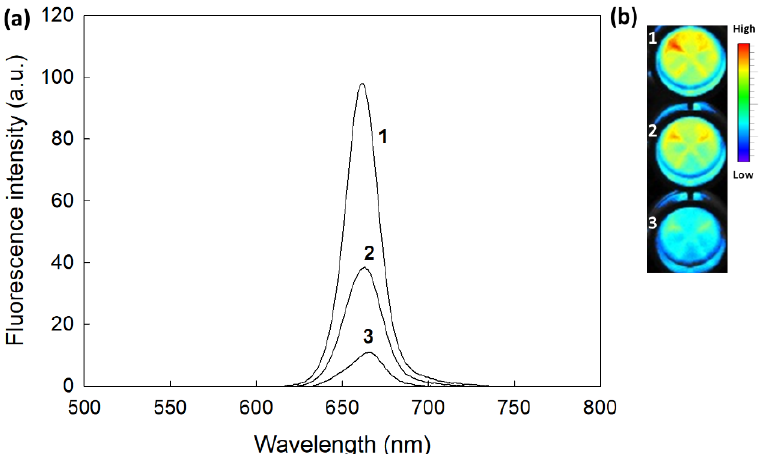
Figure 6. The effect of ROS on the changes in the fluorescence spectra ( a ) and fluorescence image ( b ) of nanophotosensitizers. Nanophotosensitizers were incubated for 3 h at 37 °C in the absence or presence of H 2 O 2 . 1. H 2 O 2 , 0 mM; 2. H 2 O 2 , 0.5 mM; 3. H 2 O 2 , 2.0 mM. The Ce6 concentration of the nanophotosensitizers in PBS was 0.05